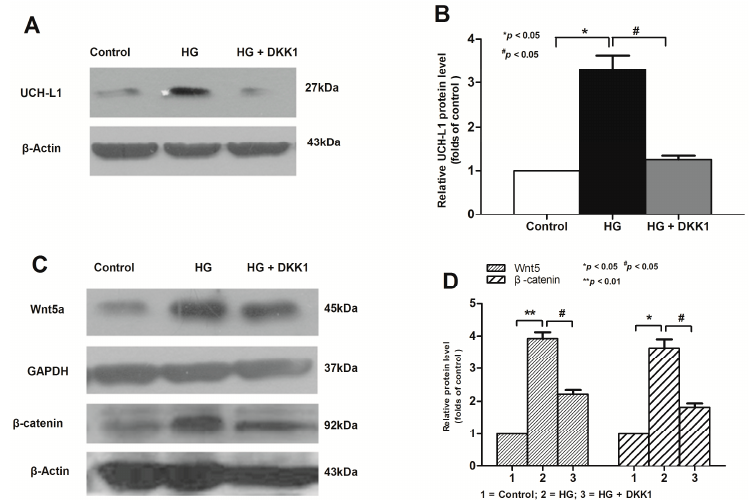
Figure 3. Inhibition of the Wnt/ β -catenin pathway downregulated HG-induced UCH-L1 expression. Podocytes were stimulated with HG or HG + DKK1 (200 ng/mL) for 48 h. ( A ) Western blot assay of UCH-L1 protein level; ( B ) corresponding statistic histogram of UCH-L1 protein expression; ( C ) western blot assay of Wnt5a and β -catenin protein level; ( D ) corresponding statistic histogram of Wnt5a and β -catenin expression. Data representative of three independent experiments. * p < 0.05, ** p < 0.01 compared to control group. # p < 0.05 compared to HG + DKK1 group.